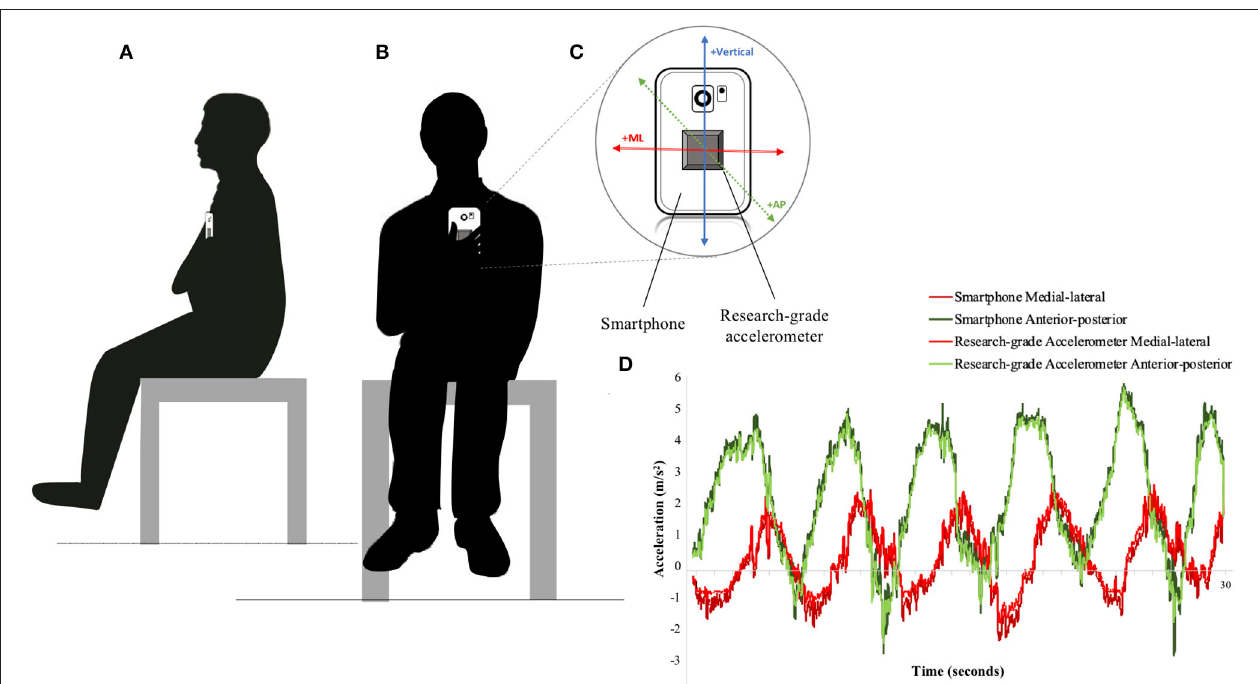
FIGURE 1 | Illustration of two participants completing the seated postural control assessment. (A) represents a participant facing the side, (B) represents a participant facing forward, (C) depicts the research-grade accelerometer affixed to the back of the smartphone and the aligned axes orientation (ML, medial-lateral; AP, anterior-posterior), and (D) provides an example plot of accelerometry data from the smartphone and research-grade accelerometer, recorded during the Functional Stability Boundary